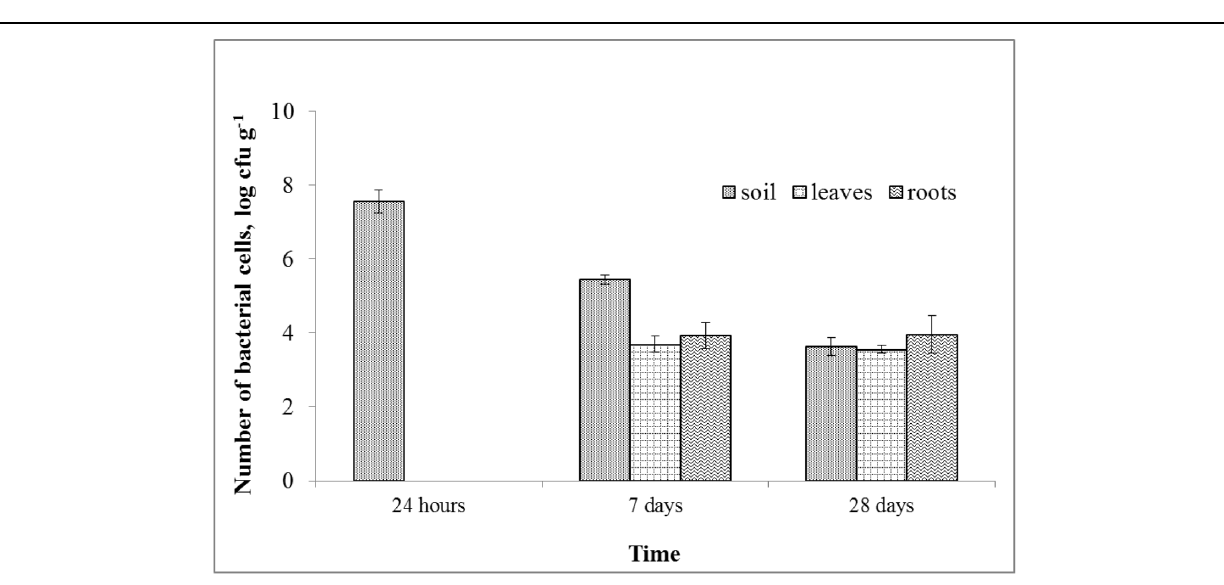
FIGURE 5 | The number of Brevibacterium casei MH8a cells isolated from soil and plant tissues 24 h, 7 and 28 days after soil inoculation with MH8a (mean ± SD, n =